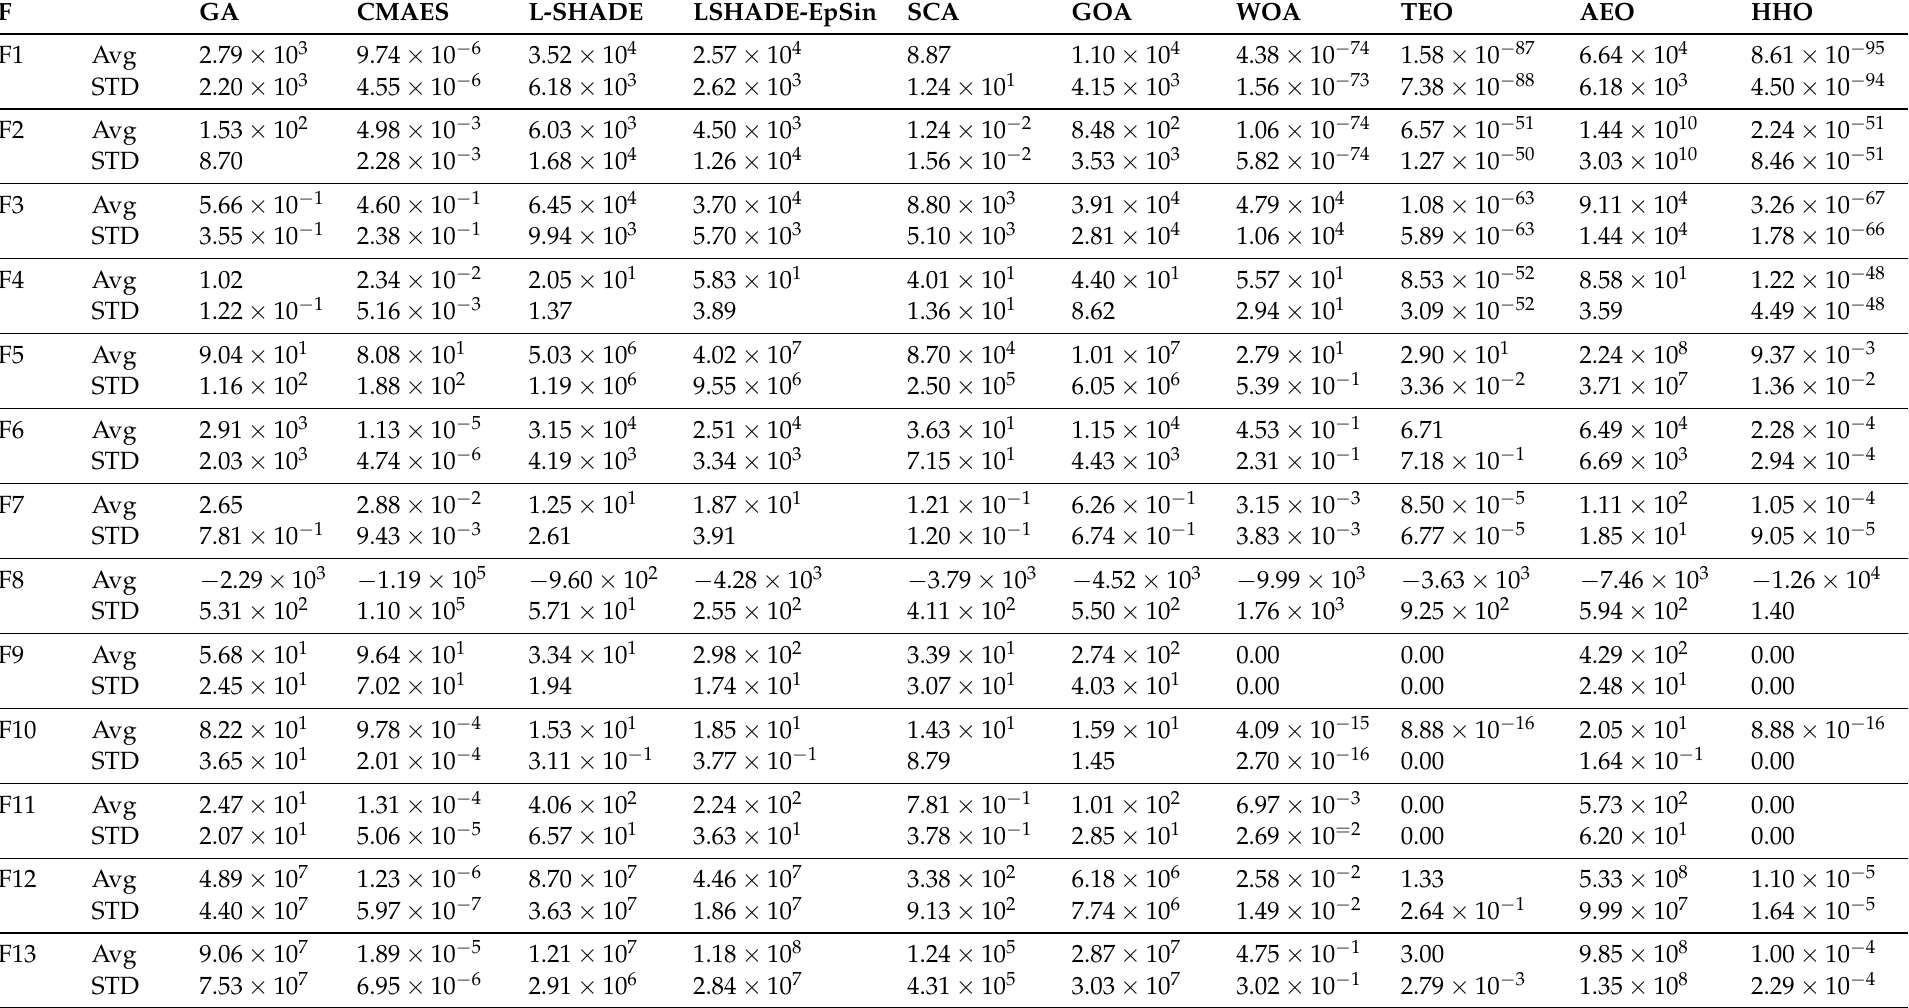
Table 4. The comparison results of all algorithms over 23